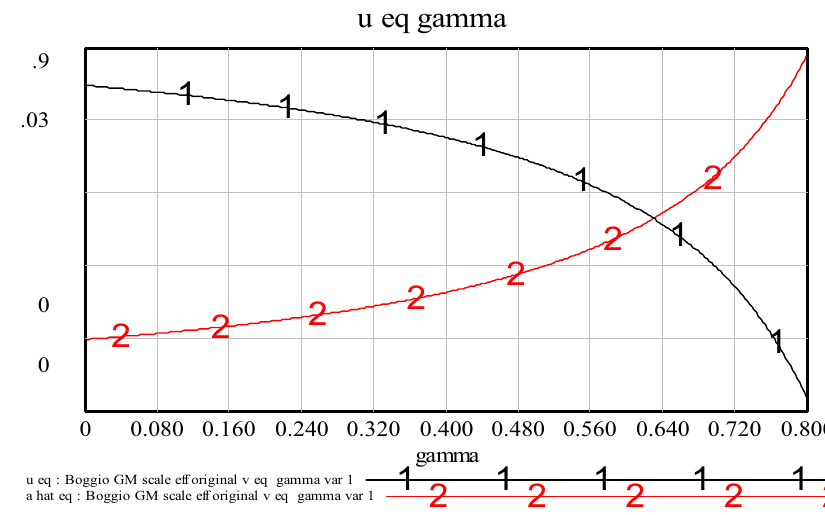
Fig. 2 The negative dependence of the stationary relative wage (1) and positive dependence of the stationary growth rate of output per worker (2) on parameter γ < γ